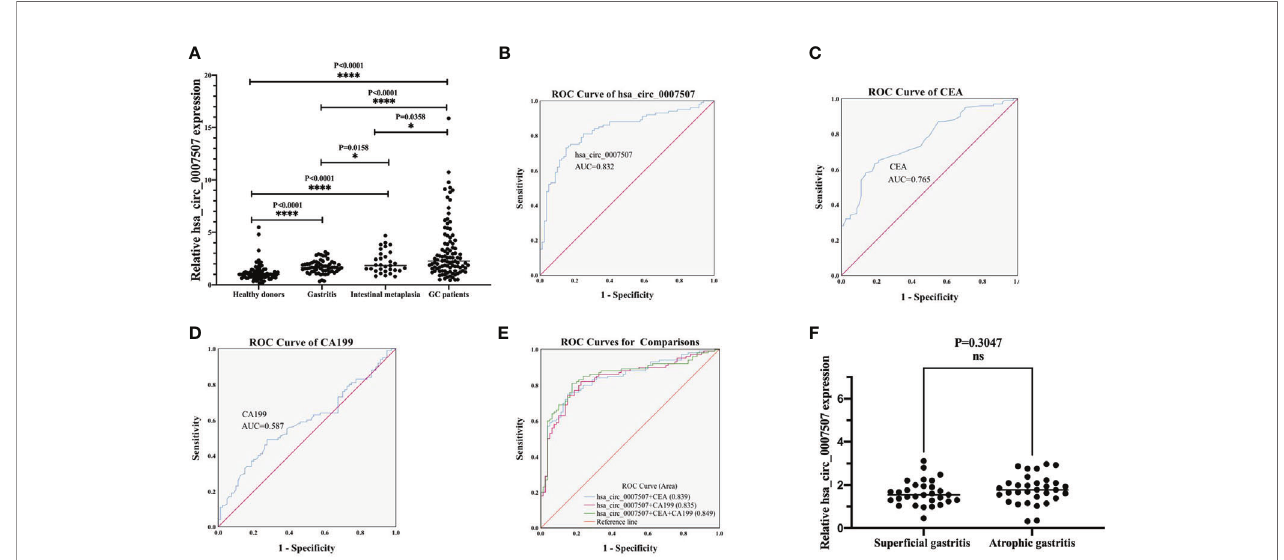
FIGURE 3 | Evaluation of the diagnostic value of hsa_circ_0007507. (A) Differential expression of hsa_circ_0007507 in the serum of healthy donors (n=80), gastritis patients (n=62), intestinal metaplasia patients (n=31), and GC patients (n=100). (B) ROC curve analysis of serum hsa_circ_0007507 for discriminating GC patients and healthy donors (AUC=0.832). (C) The diagnostic ef fi cacy of CEA (AUC=0.765). (D) The diagnostic ef fi cacy of CA199 (AUC=0.587). (E) Combined diagnostic of serum hsa_circ_0007507, CEA and CA199 exerted the best diagnostic ef fi cacy in distinguishing GC patients and healthy donors (AUC=0.849). (F) Differential expression of hsa_circ_0007507 in the serum of super fi cial gastritis patients (n=30) and atrophic gastritis patients (n=32). ROC, receiver operating characteristic curve; AUC, the area under the ROC. Indicated statistical signi fi cance (* p < 0.05, **** p < 0.0001).